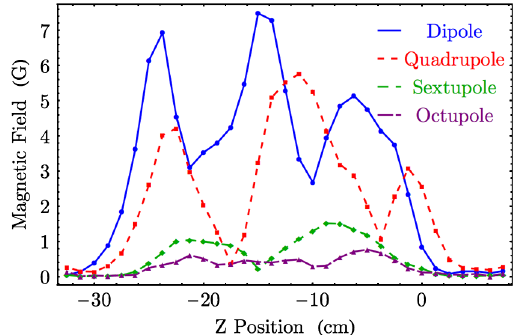
FIG. 10. Multipole magnetic field measurements of the emit- tance compensation solenoid at the maximum current of 300